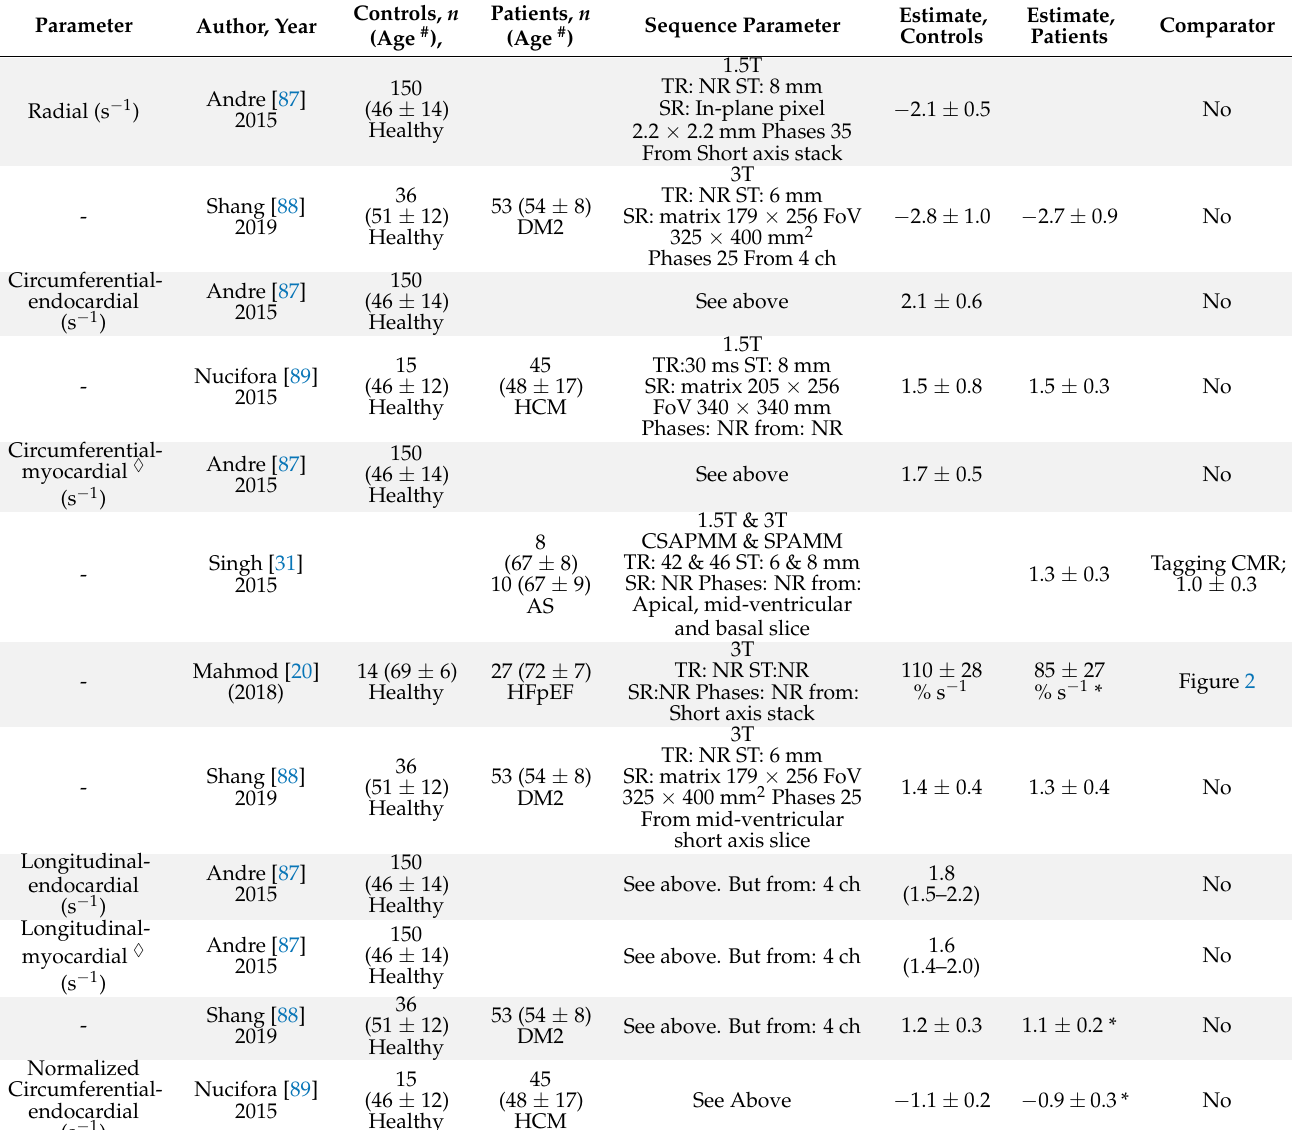
Table 12. LV feature tracking—peak diastolic strain rate.